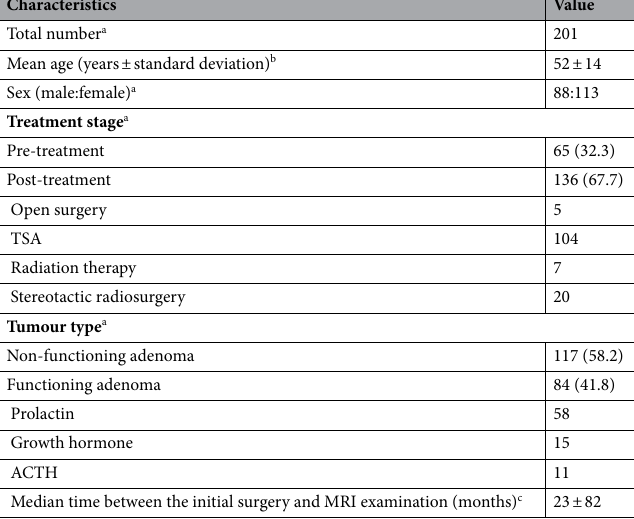
Table 1. Demographic and clinical variables of the study patients. TSA transsphenoidal surgery, ACTH adrenocorticotropic hormone, MRI magnetic resonance imaging. a Data are expressed as count, with percentage in parentheses. b Data are expressed as mean, with standard deviation. c Data are expressed as median, with interquartile range.